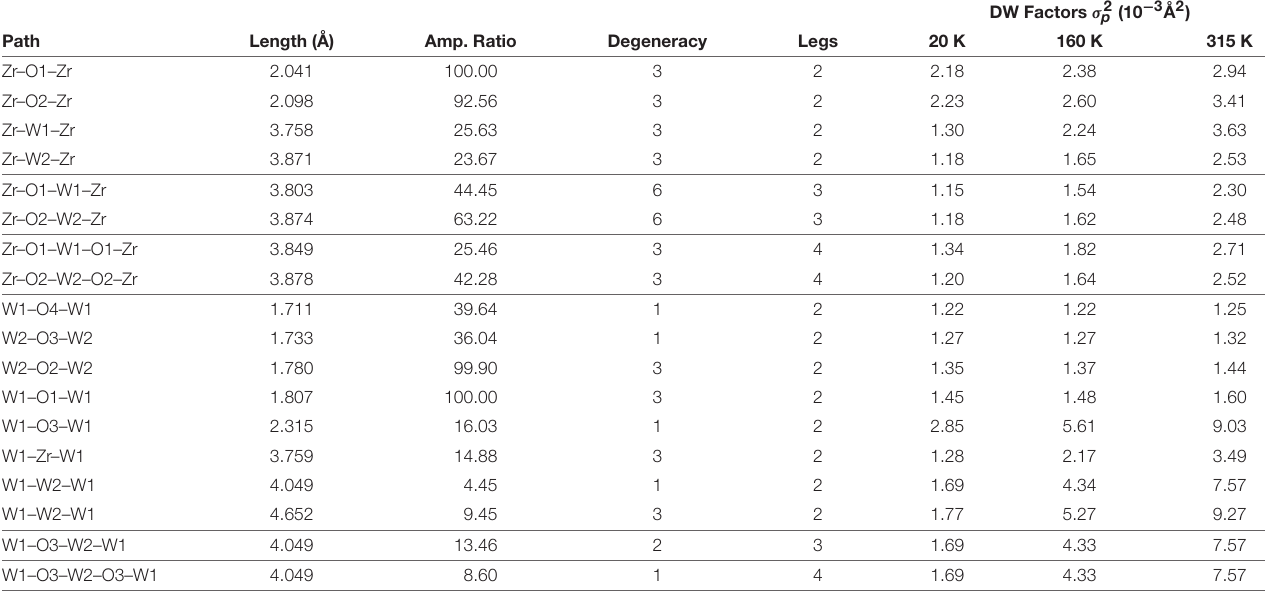
TABLE 2 | Properties of some selected Zr and W